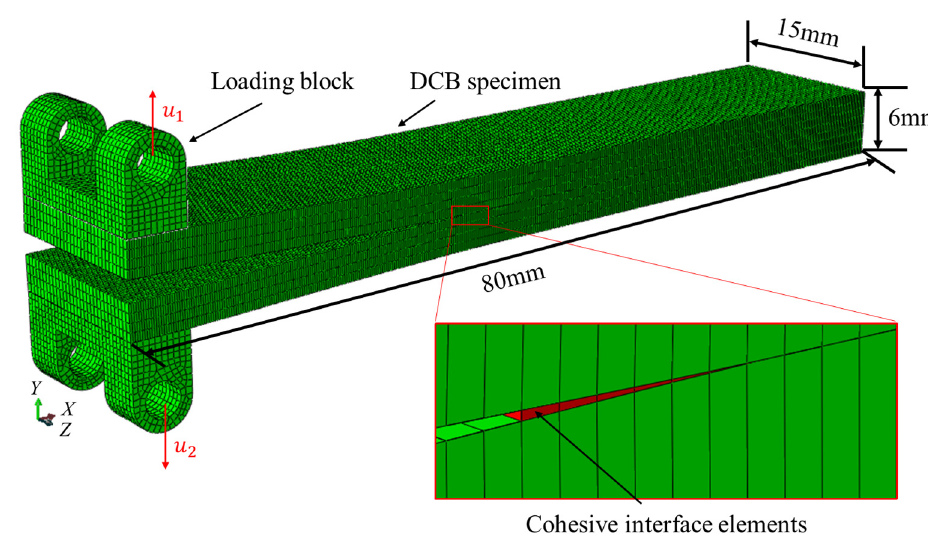
Figure 3. Finite element model of DCB test.